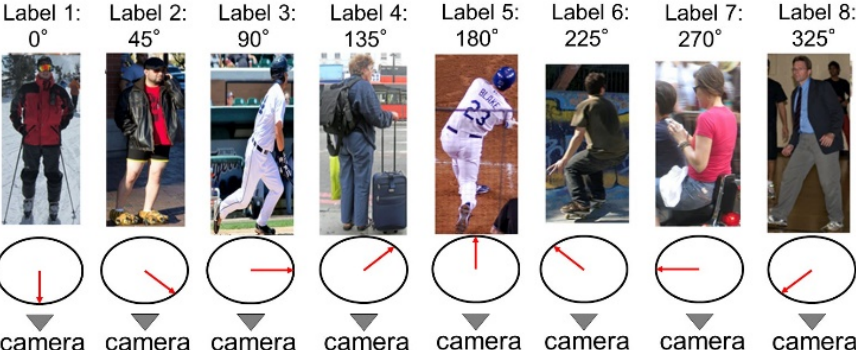
Figure 6. The representations of body orientations.